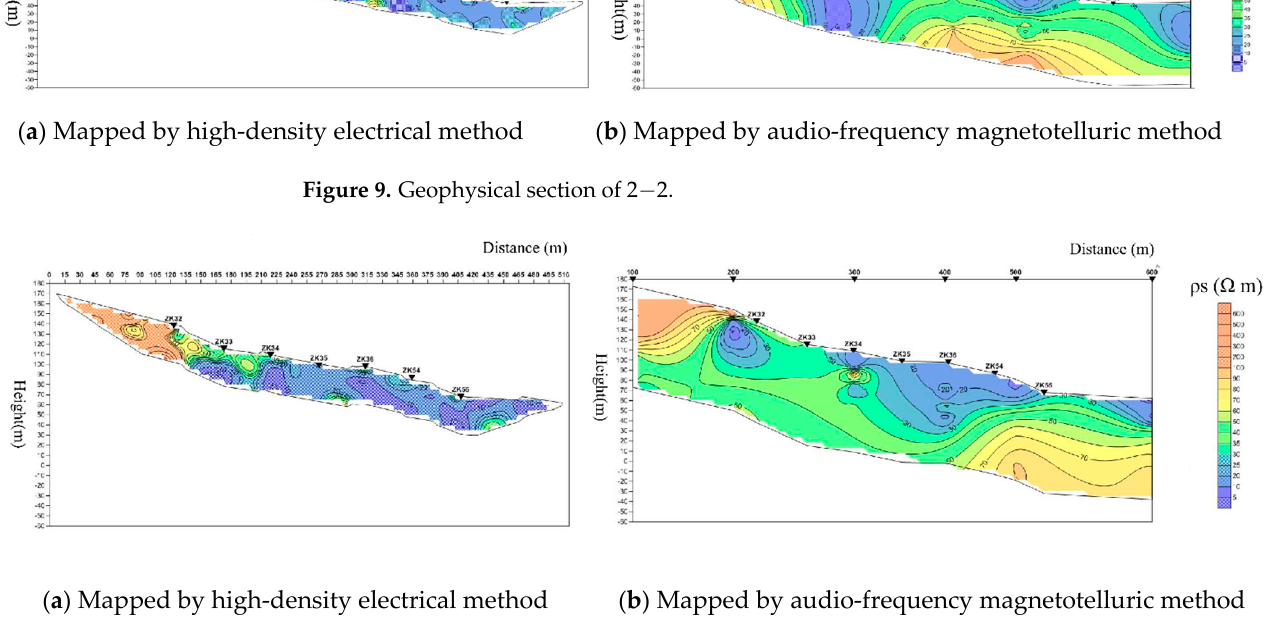
Figure 10. Geophysical section of 3 − 3.